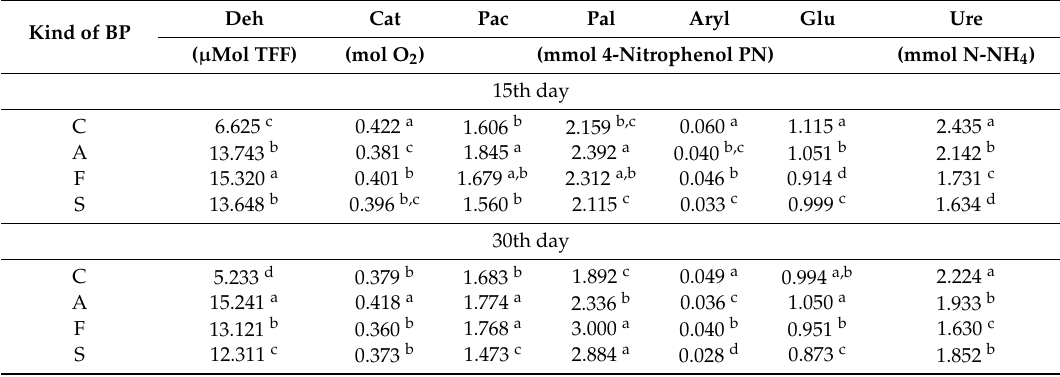
Table 3. Enzymatic activity in soil contaminated with BPA, BPF, BPS in 15th and 30th day of research, kg − 1 d.m. of soil h −